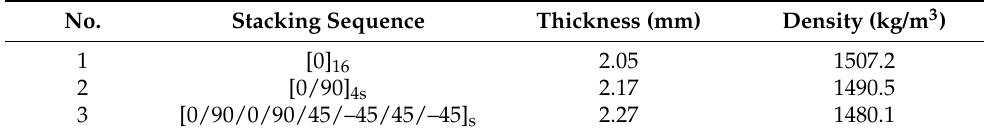
Table 2. CFRP sample specification.